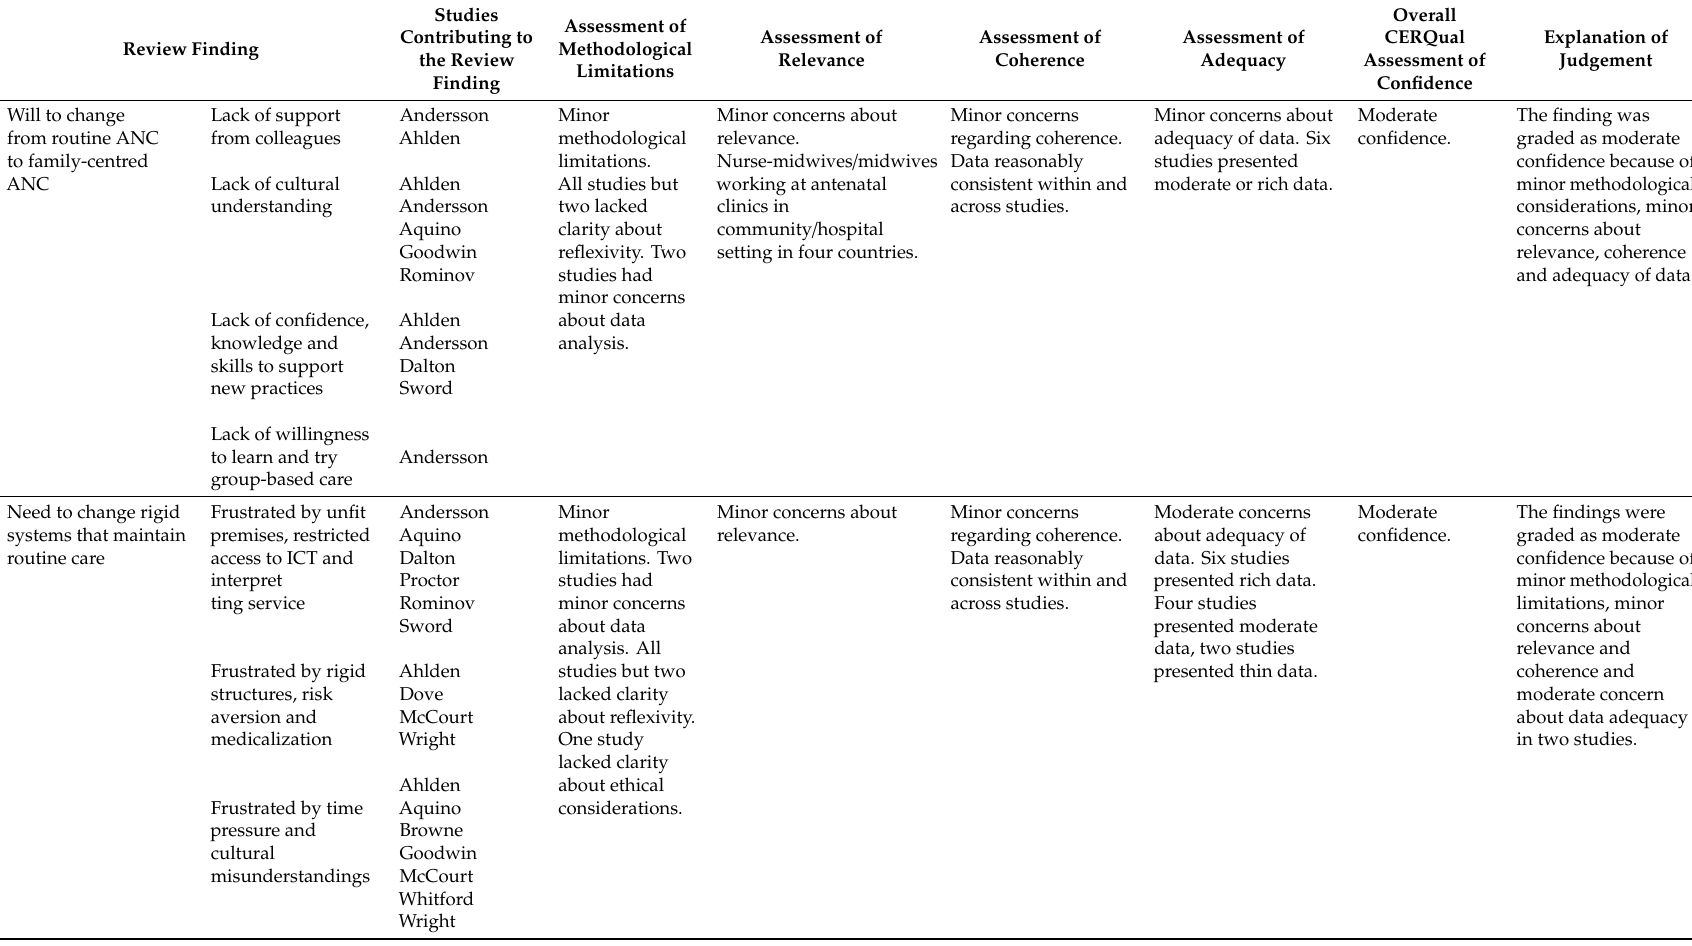
Table A2. CERQual Qualitative Evidence Profile. Check row alignment in this